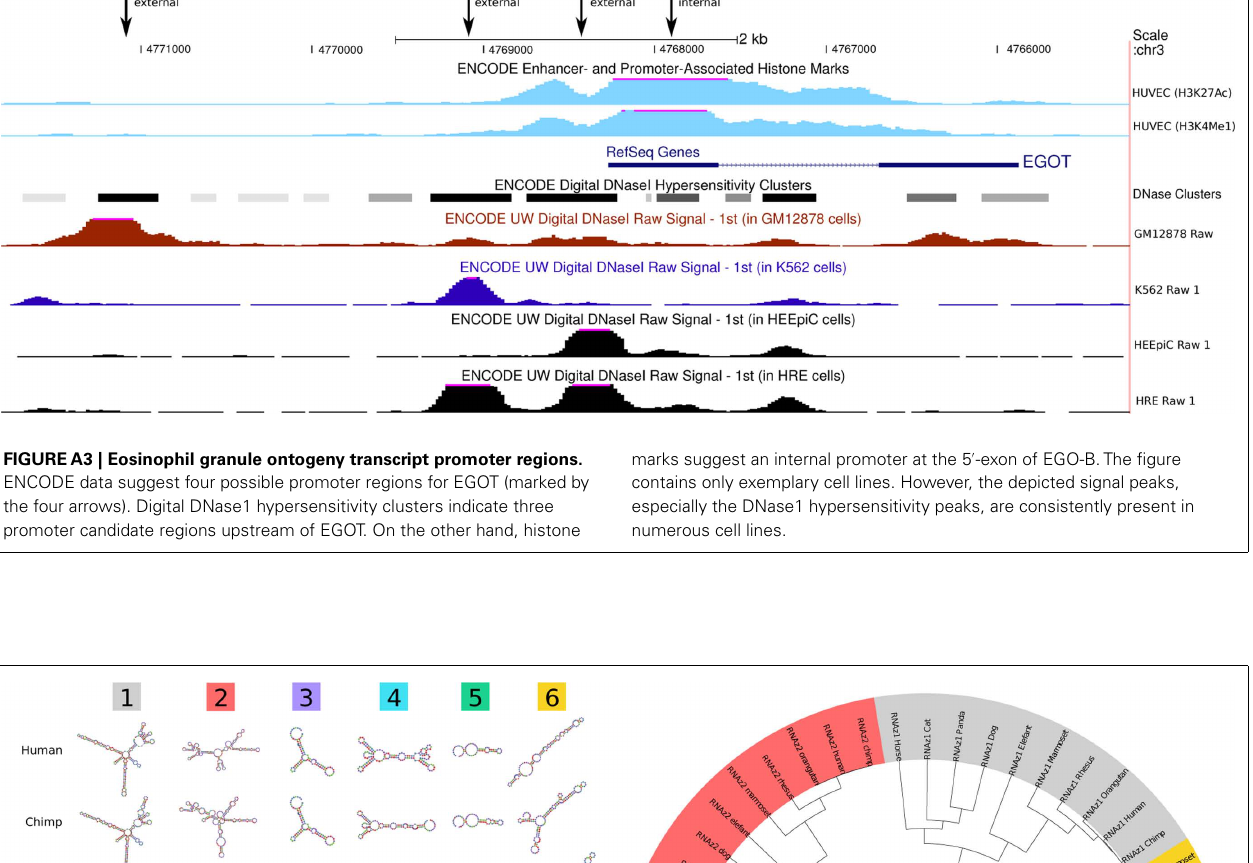
FIGUREA3 | Eosinophil granule ontogeny transcript promoter regions. ENCODE data suggest four possible promoter regions for EGOT (marked by the four arrows). Digital DNase1 hypersensitivity clusters indicate three promoter candidate regions upstream of EGOT. On the other hand, histone